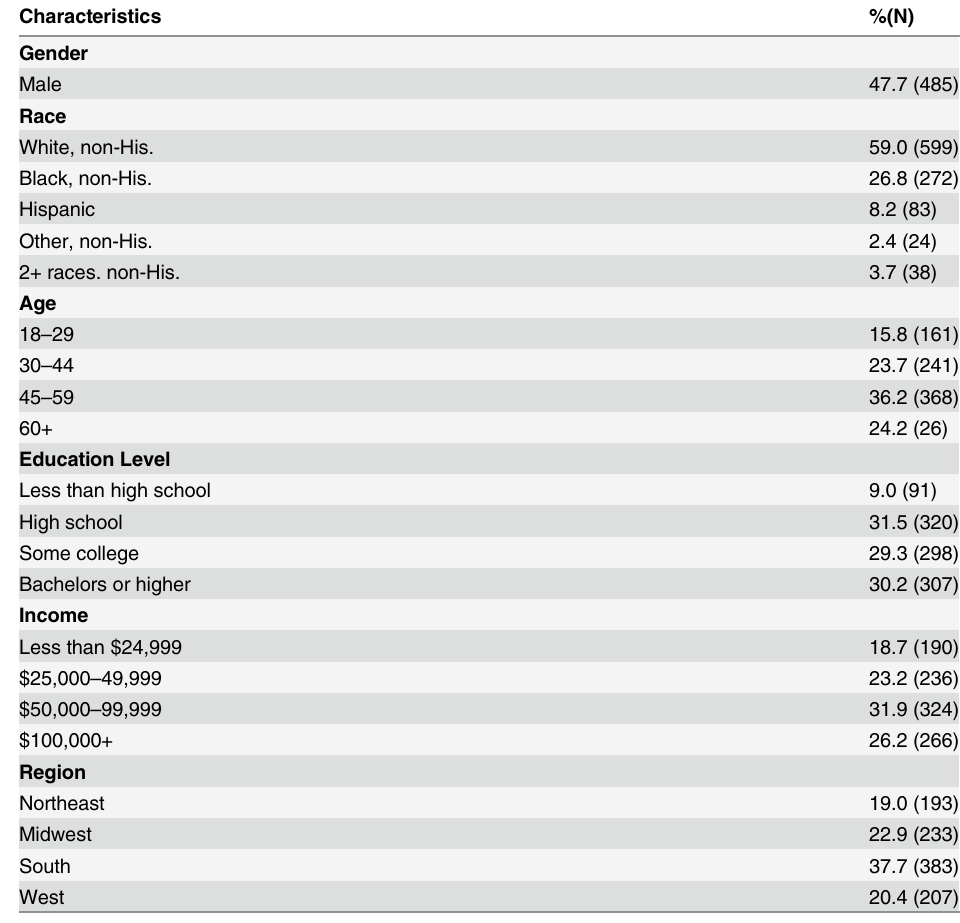
Table 1. Sample Characteristics (N = 1016).